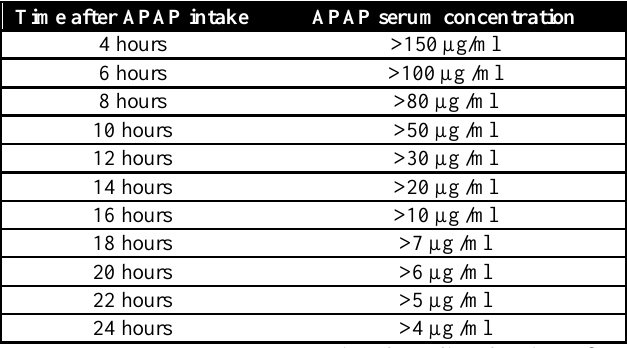
Table 2: APAP serum concentration depending the time after APAP intake. APAP: